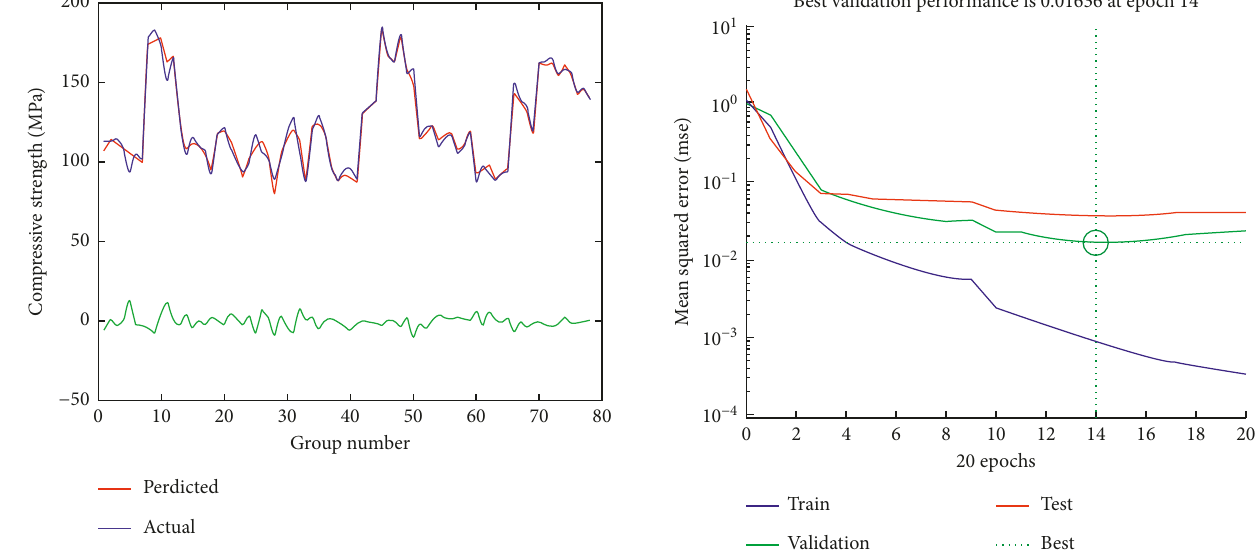
Figure 8: Evaluation of the model for compressive strength.